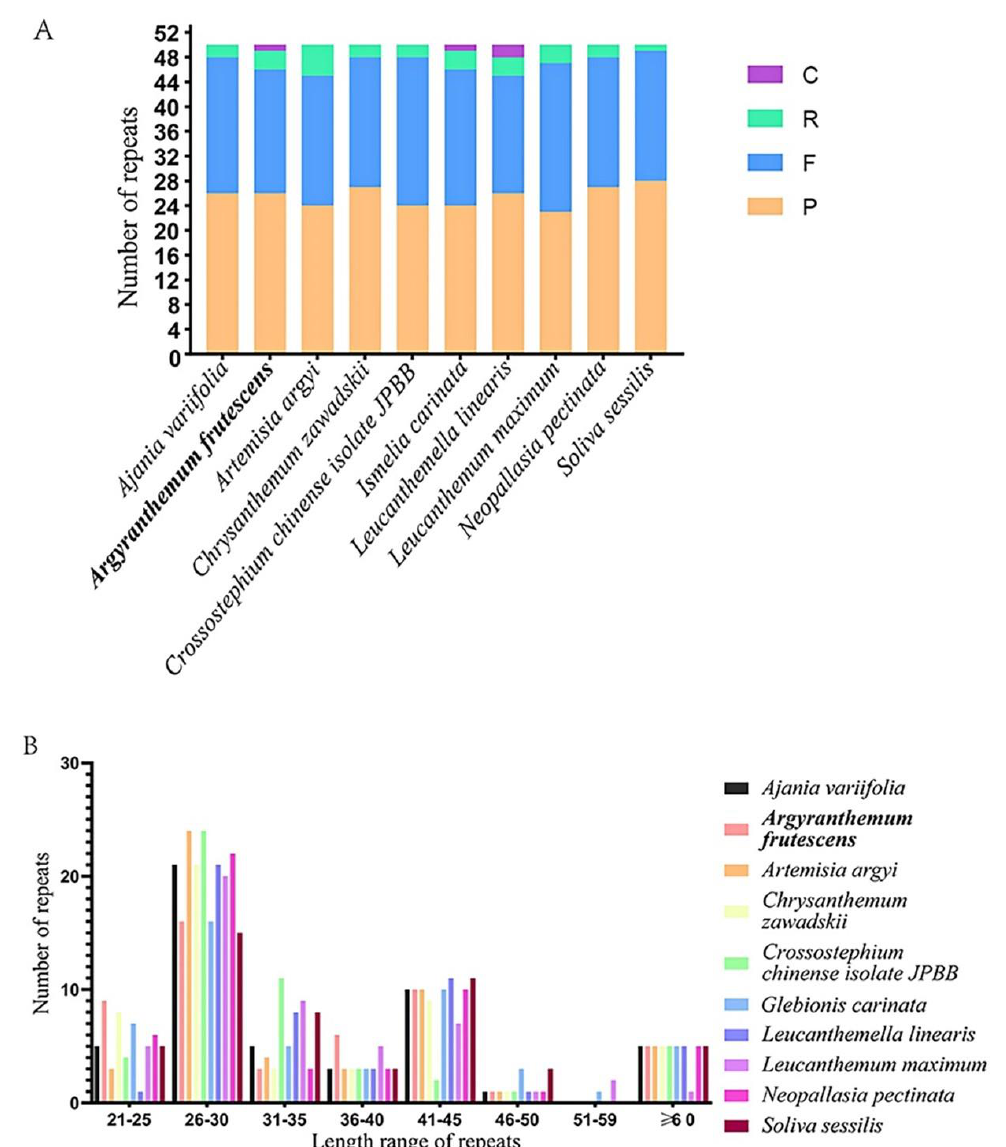
Figure 2. The long repetitive sequences of 10 chloroplast genomes. ( A ) Number of identified repeats. F, forward repeats; P, palindromic repeats; R, reverse repeats; C, complementary repeats. ( B ) Number of different repeat types of different lengths in 10 chloroplast genomes.